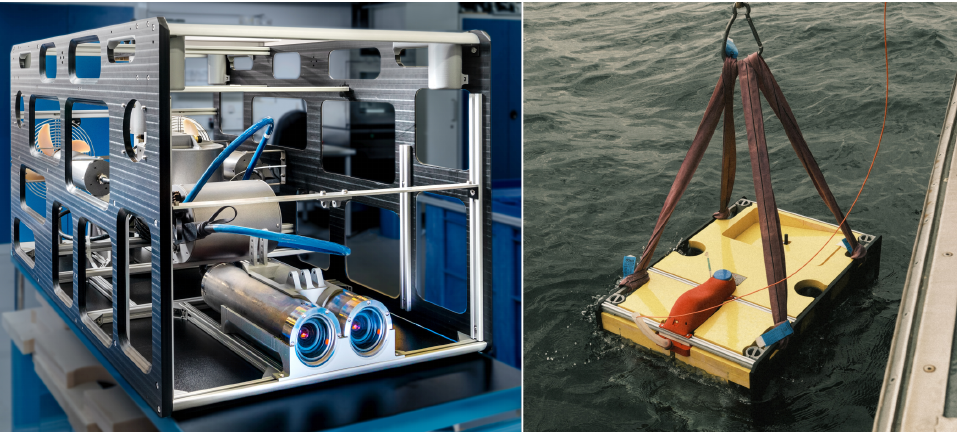
Figure 11. The underwater vehicle for the mobile setup, photographed in the laboratory and during its deployment in the